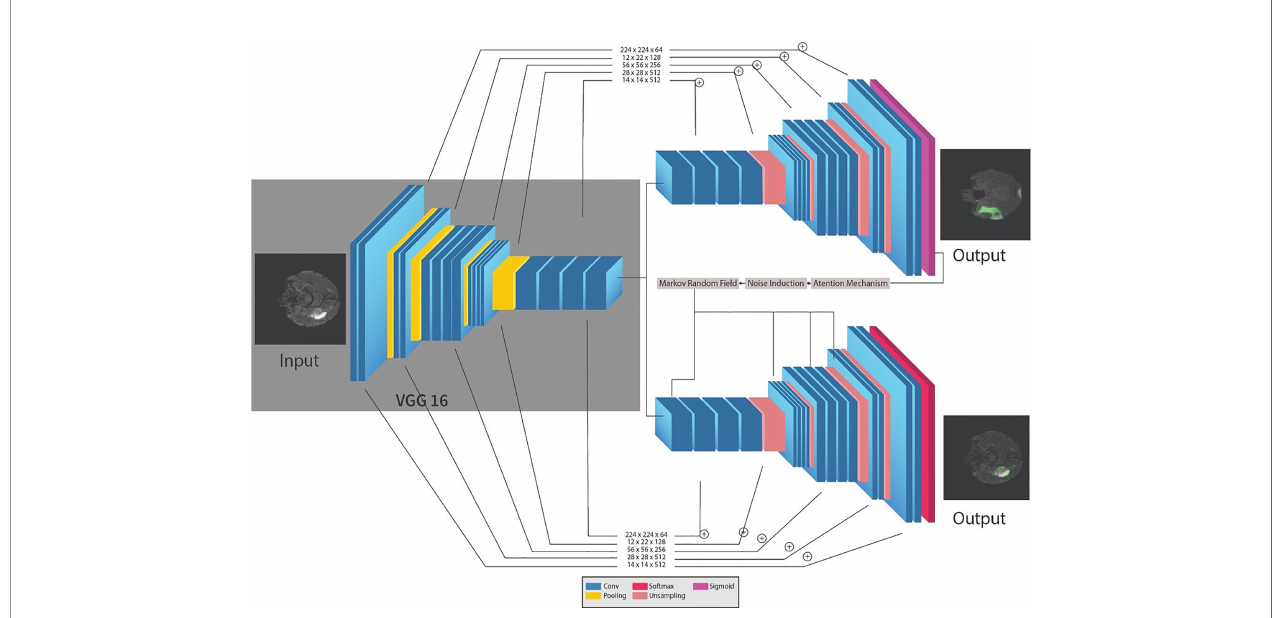
FIGURE 2 | Proposed sequential framework for segmentation of brain